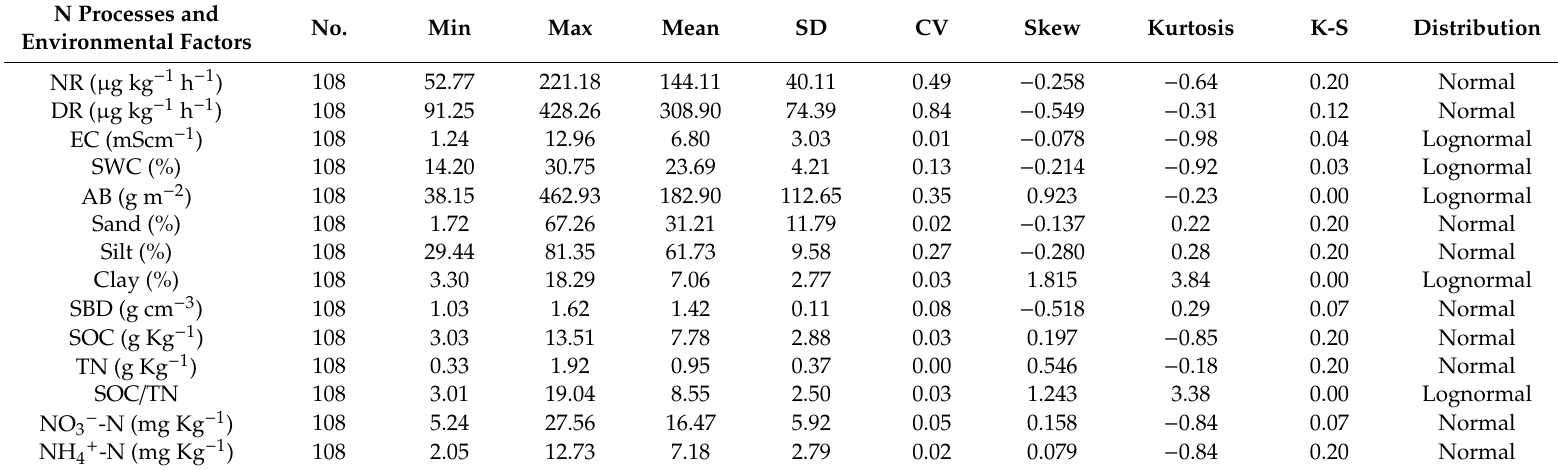
Table 1. Descriptive statistics of soil nitrification and denitrification rates, soil physico-chemical properties and aboveground biomass in the studied riparian wetland in an extremely arid